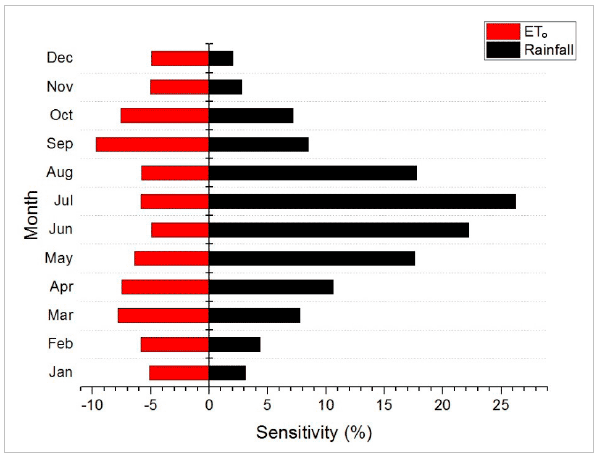
Figure 7. The sensitivity of the salt transport model to 30% variations in monthly ET 0 and Rainfall expressed as the percentage change in the total exported salt.